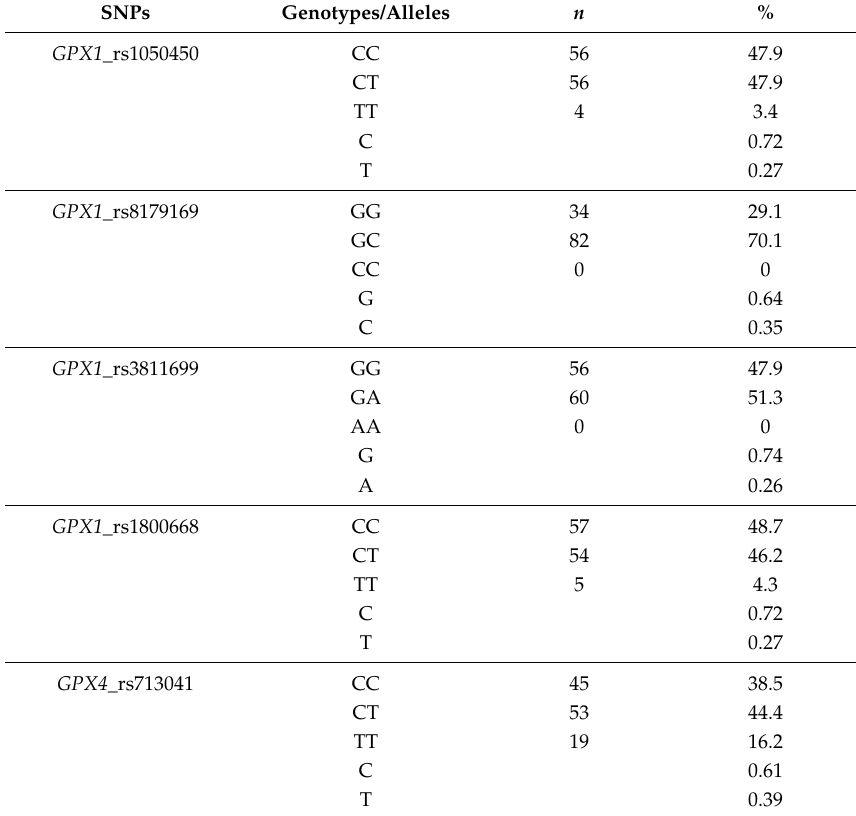
Table 2. Genotypes and allele frequencies for polymorphisms in GPX1 and GPX4